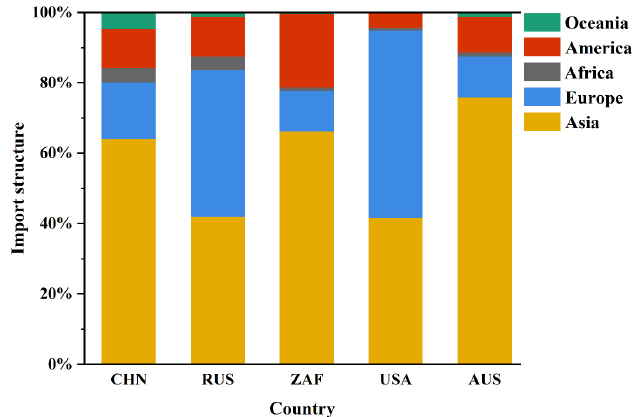
Figure 6. Trade-related CO 2 emission structure from coal production.